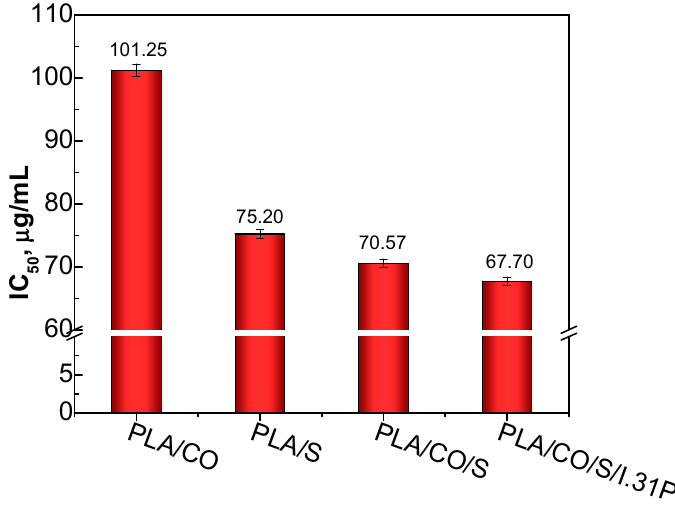
Figure 7. DPPH half maximal inhibitory concentration (IC50) values of the PLA-based biocomposites.